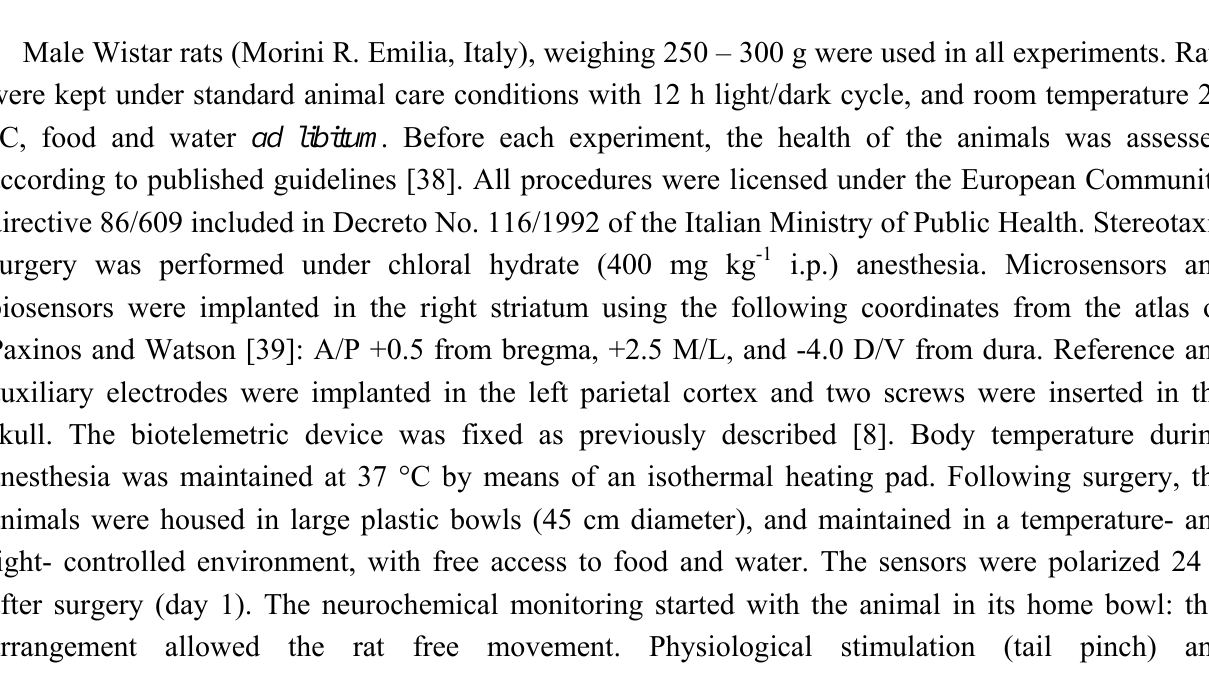
and glucose sensors. N.D.: 2